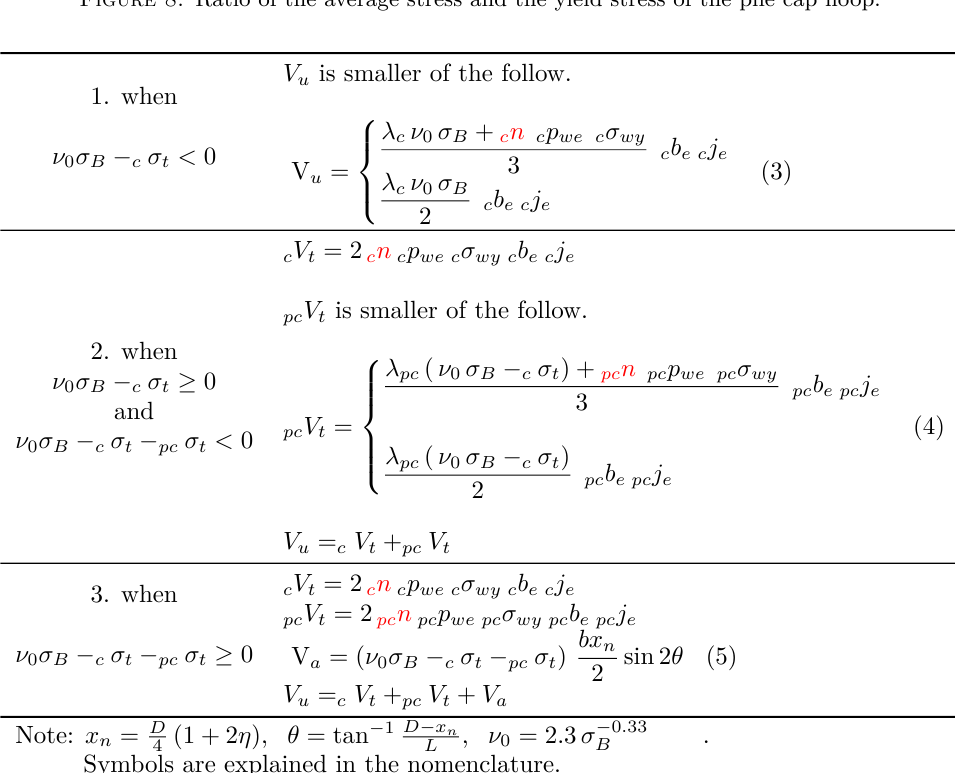
Figure 8. Ratio of the average stress and the yield stress of the pile cap hoop.